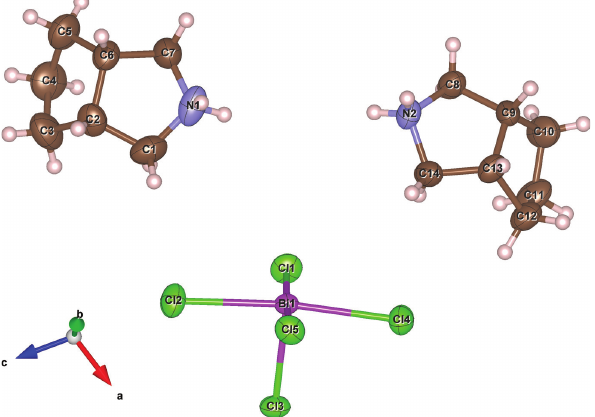
Table 2: Fractional atomic coordinates and isotropic or equivalent isotropic displacement parameters (Å 2